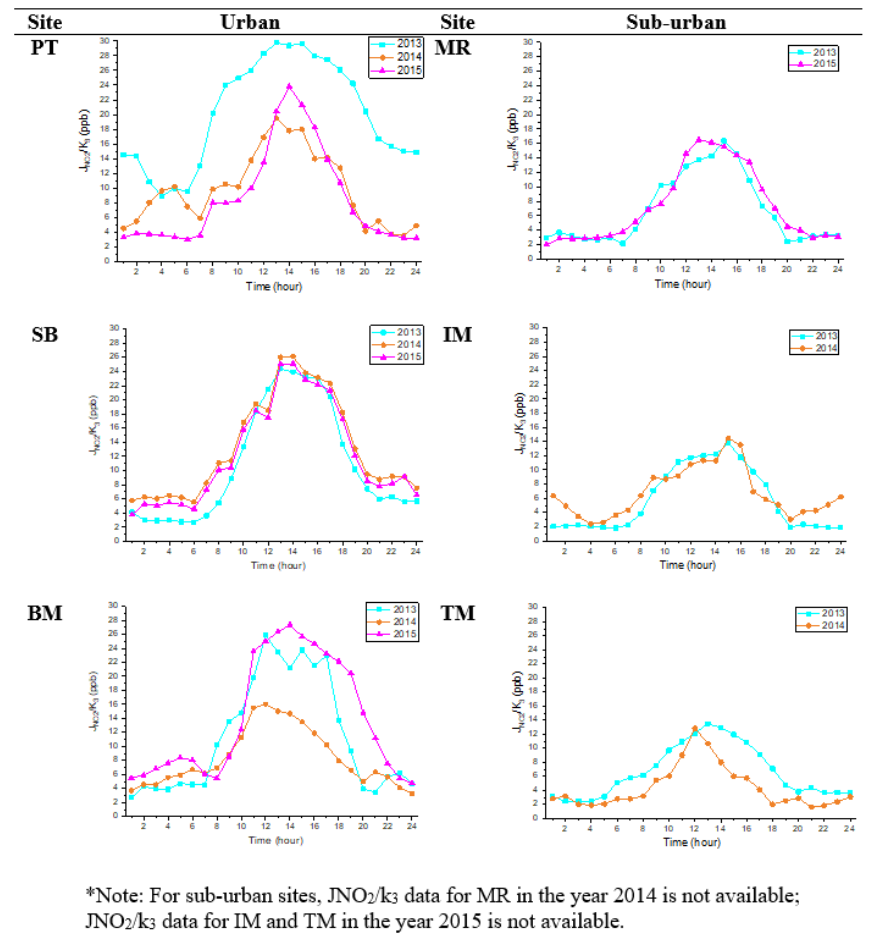
Figure 5. JNO 2 /k 3 diurnal plots at urban and suburban sites in 2013, 2014, and